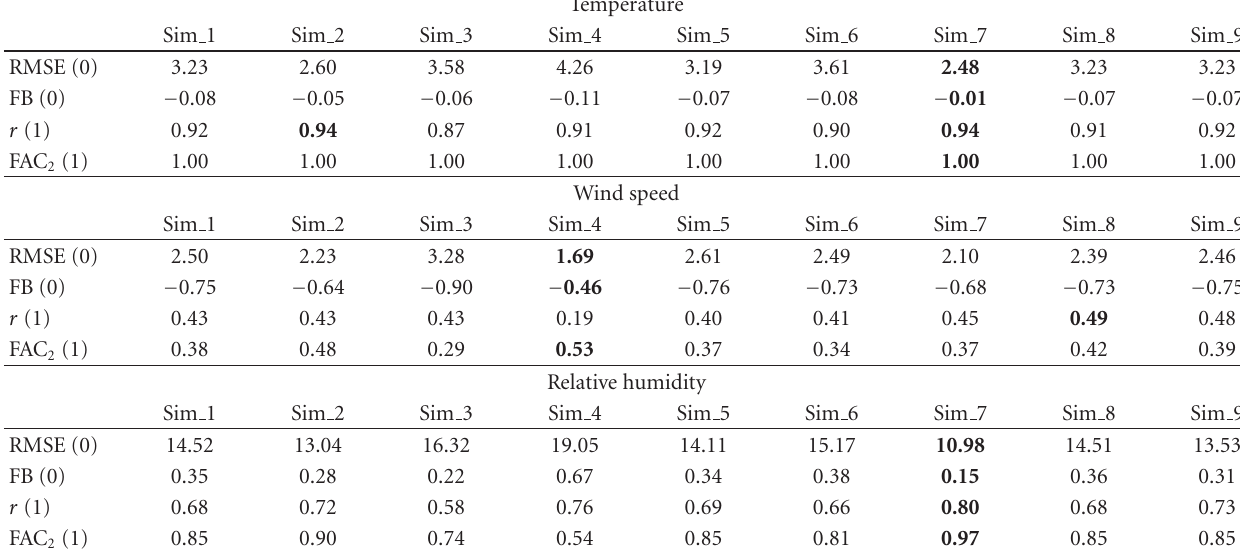
Table 4: Statistical evaluation of summer simulations, station